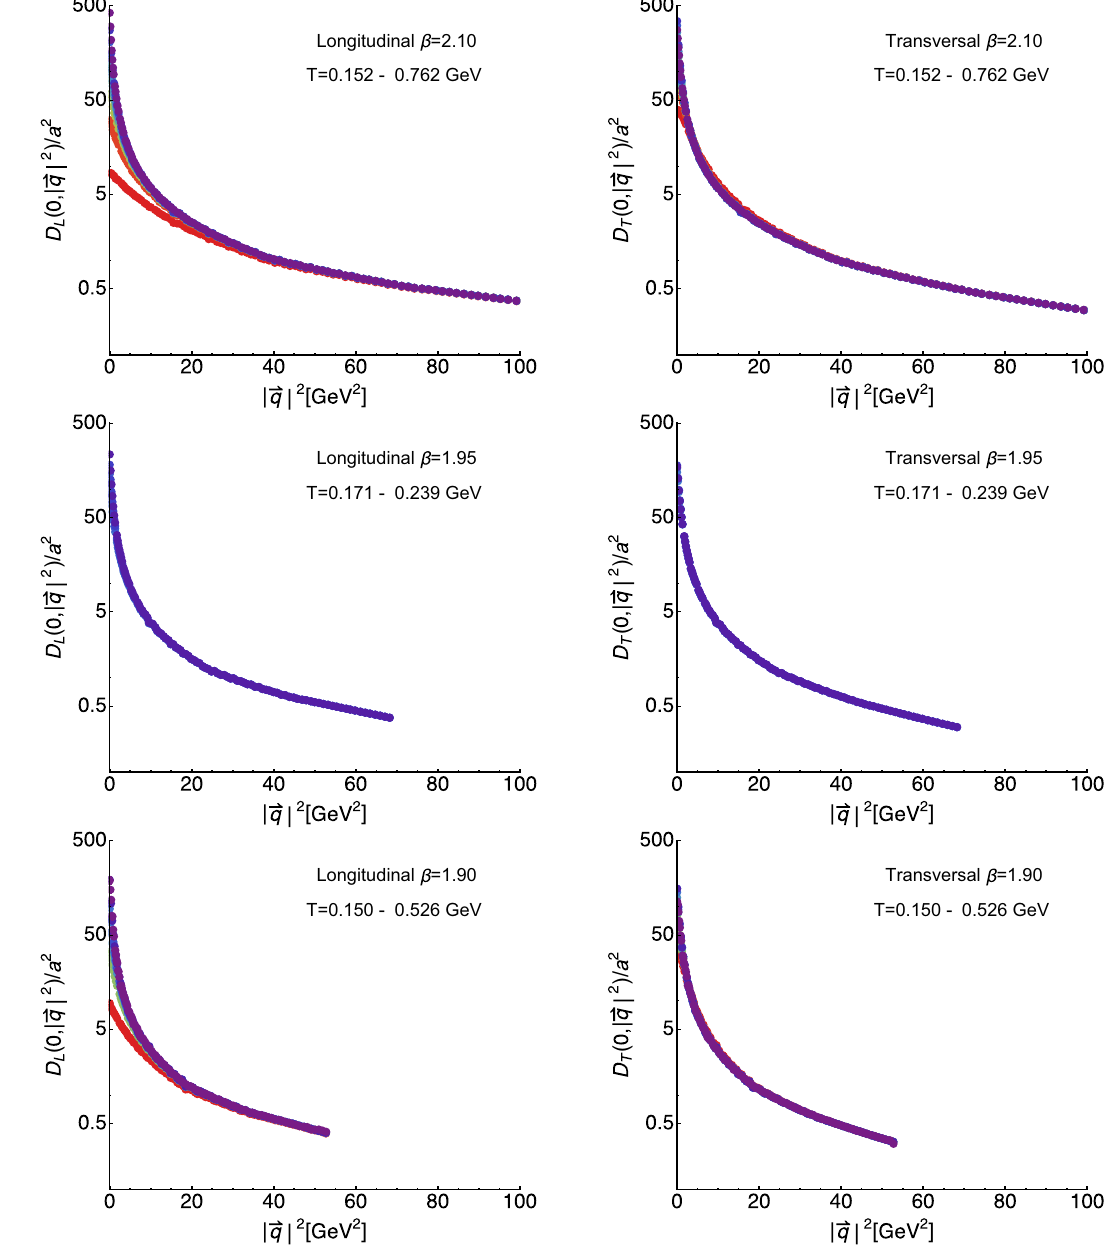
Fig. 3 For completeness we show here the longitudinal (left) and transversal (right) gluon correlators at β = 2 . 10 (top), β = 1 . 95 (middle) and β = 1 . 90 (bottom) evaluated at vanishing imaginary frequency q relator values at finite imaginary frequencies by evaluating the correlator at zero imaginary frequencies, while appro- priately shifting the finite spatial momentum D ( q 4 , | q | ) ≈ (cid:23) + | q | 2 ) . At finite temperature compactified imag- D ( 0 , q 2 4 inary time starts to play a special role and O ( 4 ) invariance is not exact anymore. It may nevertheless provide a useful approximation and using spline interpolations along spatial momenta it has been verified in continuum